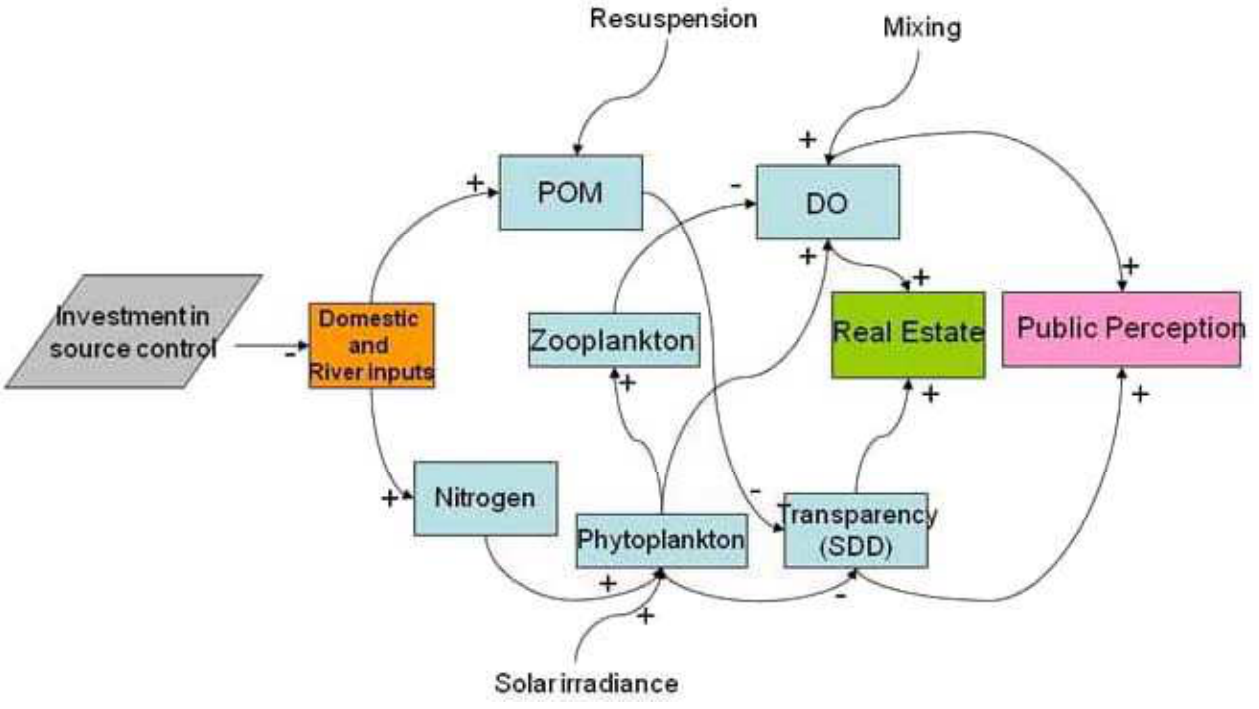
Fig. 5. The feedback loop involving the ecosystem, social, and economic (ESE) modules of the simulated system. The ecosystem components of the simulated system are embedded in an underlying circulation module (not shown in the schematic), which resolves the domain in three vertical